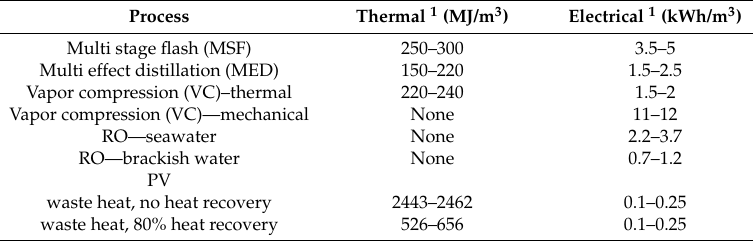
Table 4. Energy consumption for various desalination